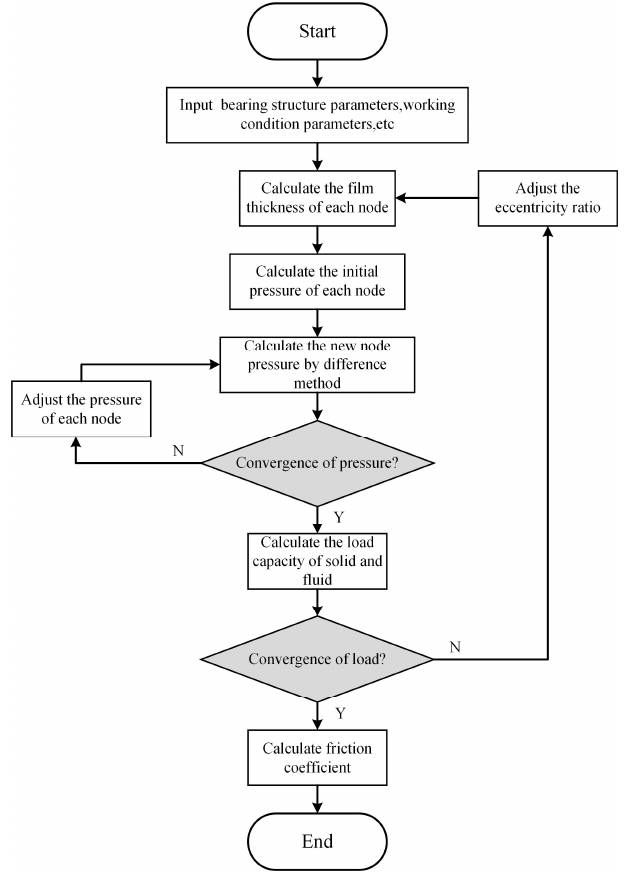
Figure 10. Flowchart of numerical solution.